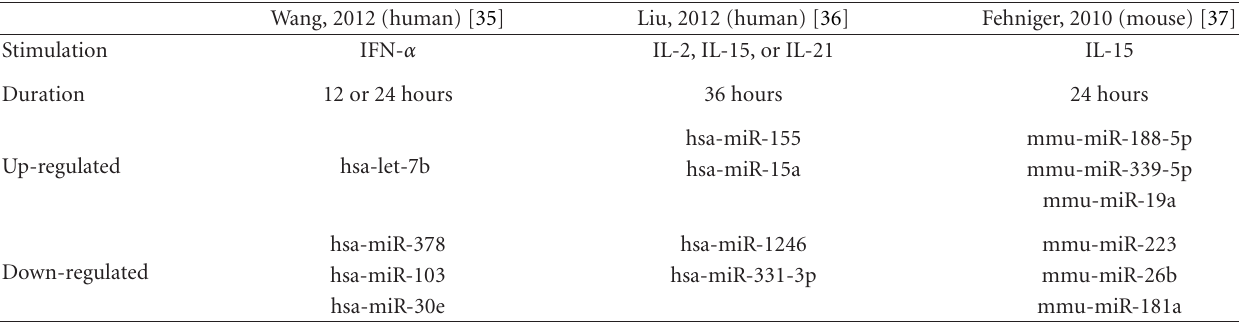
Table 2: Selected up- or down-regulated miRNAs during cytokine activation of NK cells. miRNAs were selected based on the following criteria: top three fold change within the top 12 expressed miRNAs [35], significant miRNAs consistently changed by the listed stimulation [36], and top three fold change